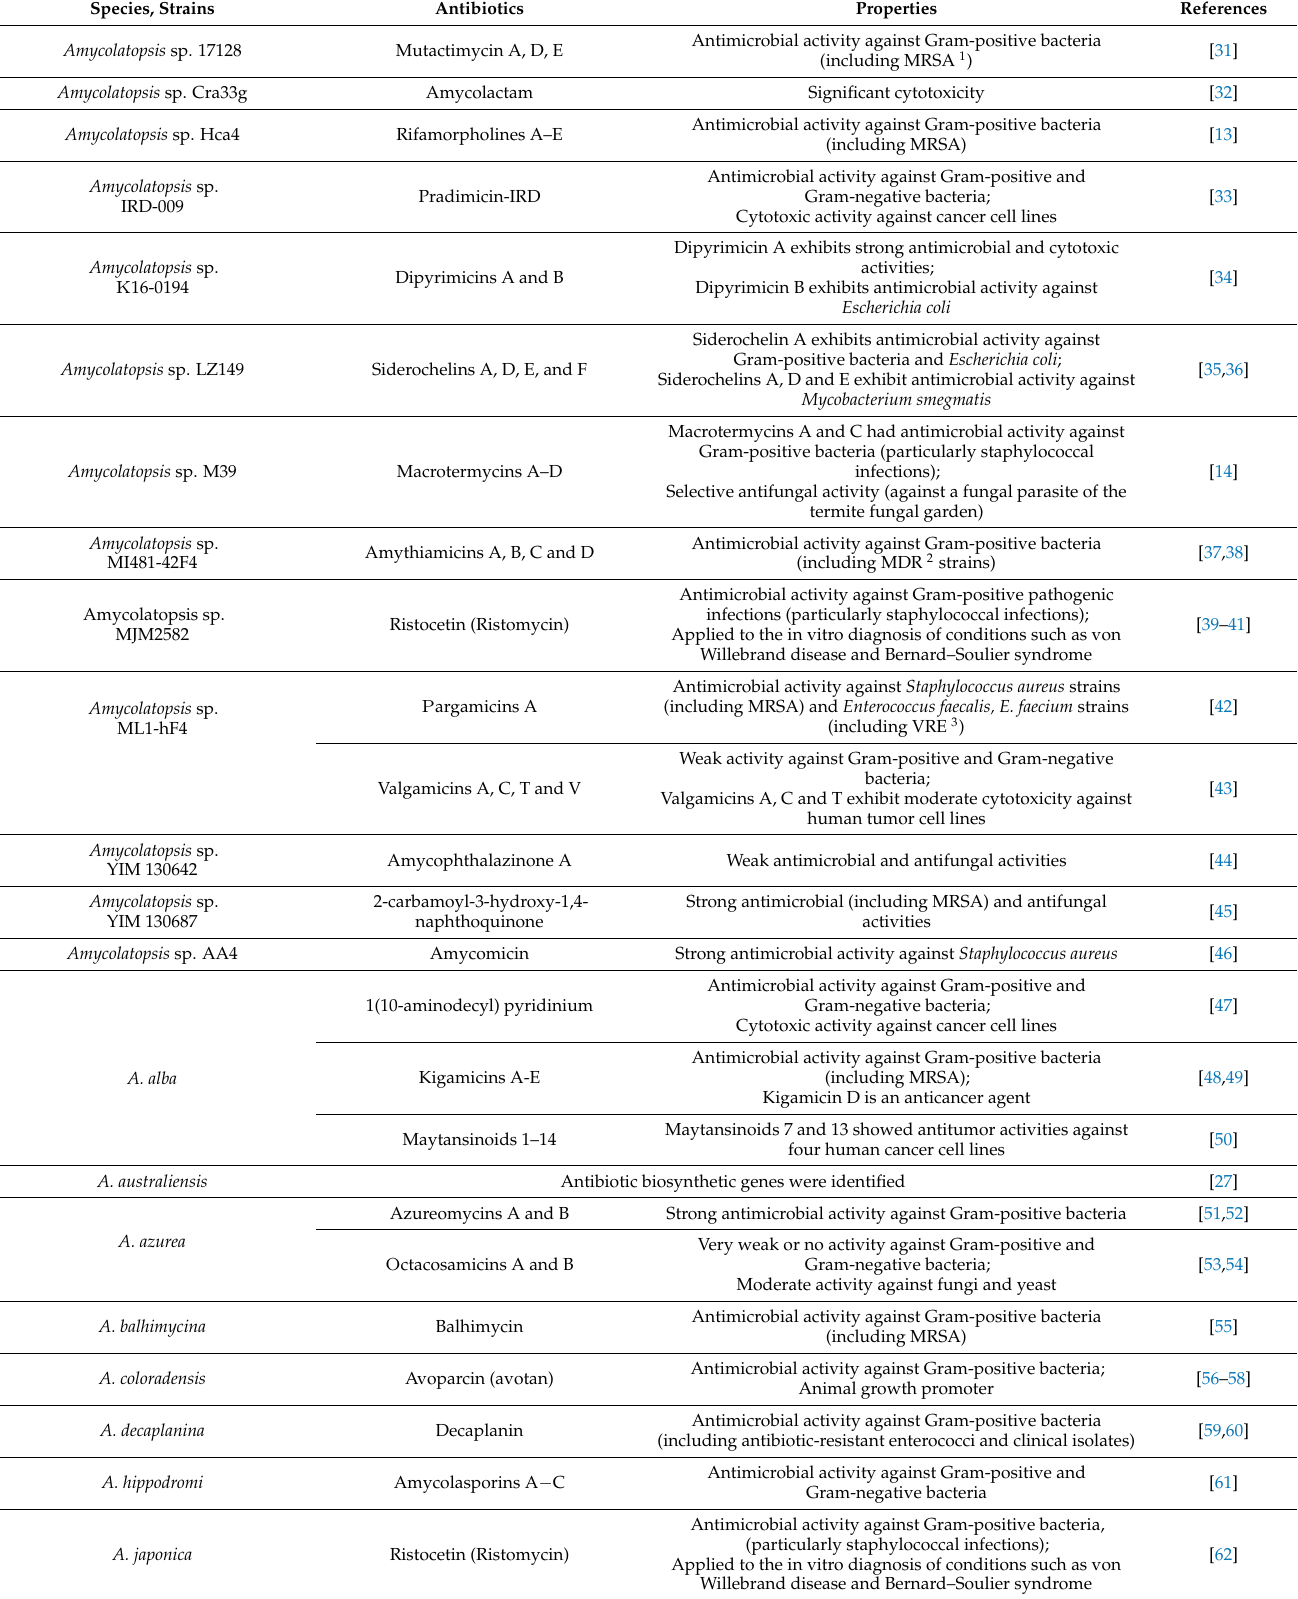
Table 2. Representatives of the genus Amycolatopsis and the antibiotics they